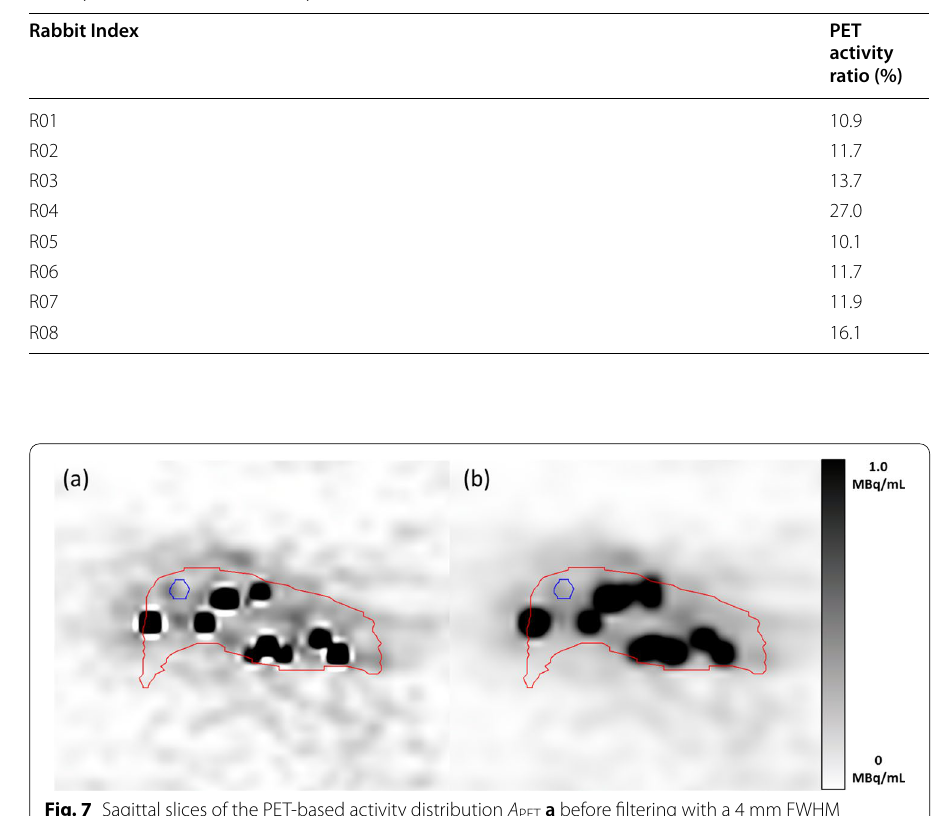
values in the ROI was 1.027